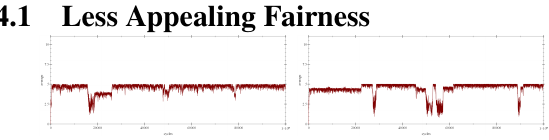
Figure 5: Periods hosting tough fair players